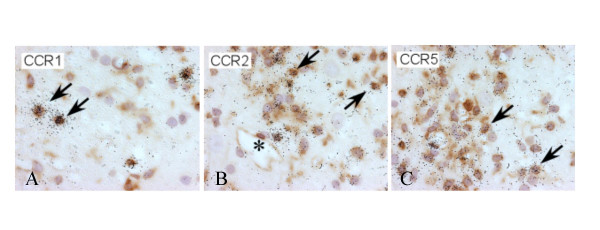
Cellular phenotype of chemokine receptor mRNA expressing cells in MOG-EAE. High magnification bright-field photomicrographs of spinal cord sections from MOG-EAE rats processed for combined GSA/B4 immunohistochemistry and CCR1, CCR2, CCR5 mRNA in situ hybridization. Cells expressing CCR1 (A), CCR2 (B) or CCR5 (C) mRNA are positively stained with GSA/B4, identifying them as macrophages/microglia.